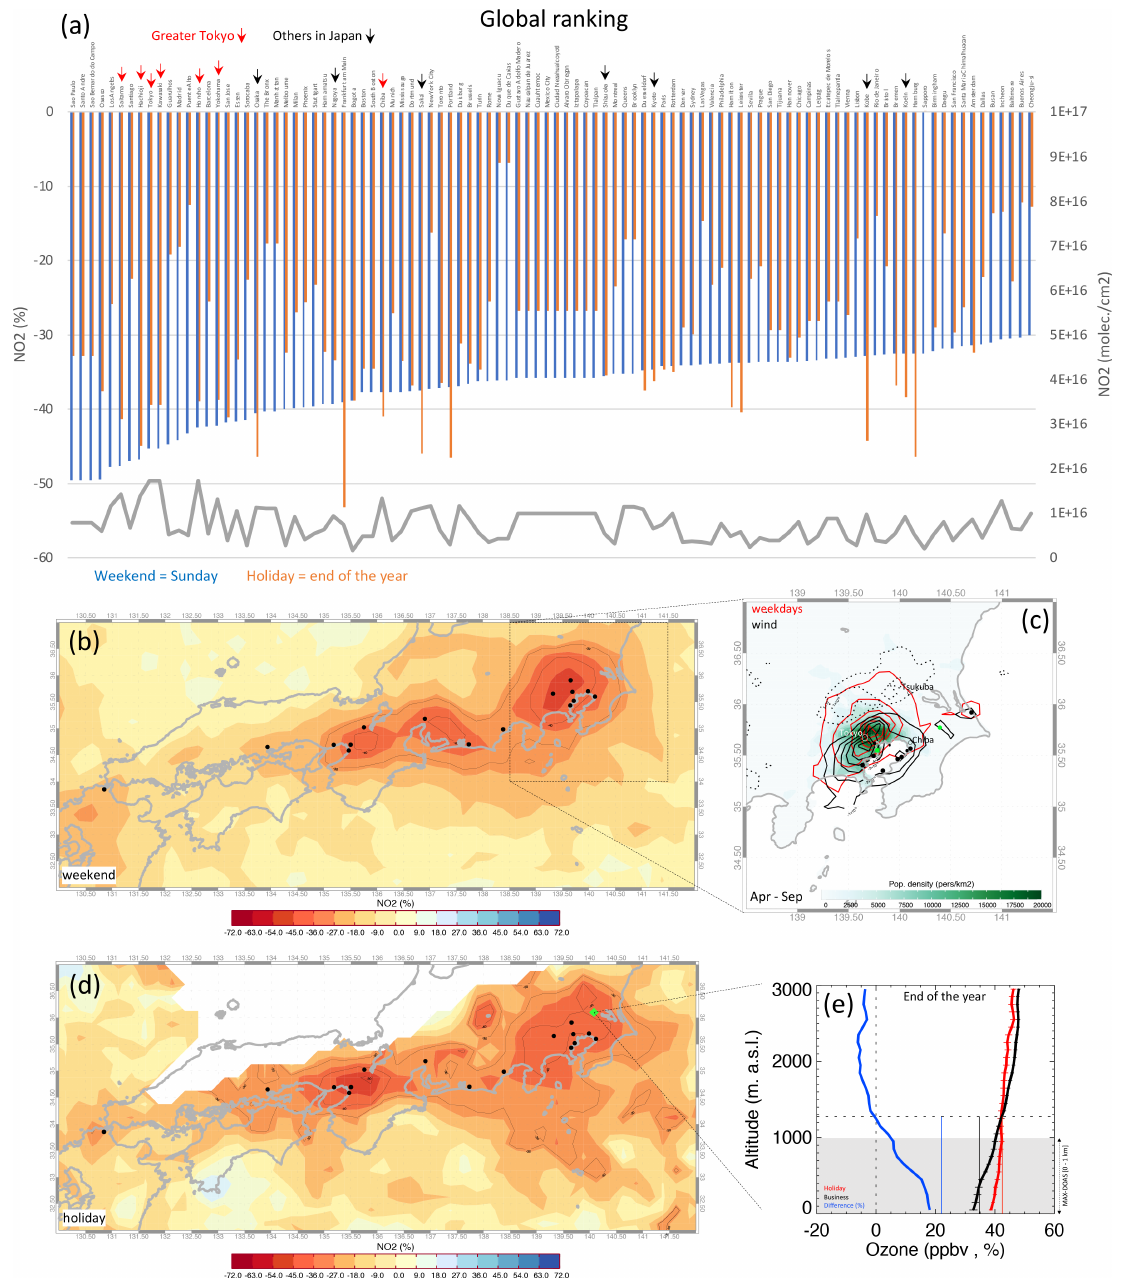
Figure 5. Global ranking of the weekend effect (Sunday minus weekdays, blue) and holiday effect (end-of-year period minus business days, orange) for cities with a population greater than 0.5 million based on OMI NO 2 in 2005–2019. Only cities where changes were larger than 30% are shown. Opposite axis: mean NO 2 total tropospheric column in grey (a) . The spatial distribution of the weekend effect over Japan ( b , relative changes) and over the Kanto region ( c , absolute changes limited to April–September; red lines: Sunday minus weekdays; black points: power plants; green points: airports). Wind-related NO 2 changes limited to April–September (black lines: high minus low wind speed) and population density (filled contours, in green shades) are also plotted in panel (c) . Contours for both red and black solid lines read as follows: − 1 × 10 15 , − 2 × 10 15 , − 3 × 10 15 , − 4 × 10 15 , − 5 × 10 15 , − 6 × 10 15 molec.cm − 2 . Then, the black dashed lines show positive changes (0 . 5 × 10 15 , 1 × 10 15 molec.cm − 2 ). Spatial distribution of the holiday effect in NO 2 across Japan (d) ; the low number of OMI observations prevents determination of the difference along the coastline of the Sea of Japan. Ozone profiles obtained from ozonesondes launched from Tateno (green point in d ) during the end-of-year holiday period and business holidays in 2013–2020 (i.e., when MAX-DOAS data were available) are plotted along with box simulations (vertical lines) of the mean ozone concentration within the boundary layer (e) . See Sect. 2 for further